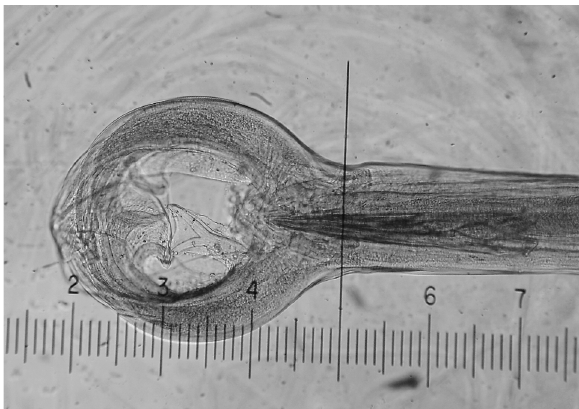
Figura 1. Exemplar macho de Haemonchus contortus , mostrando a região dos espículos com ocular micrométrica em objetiva de